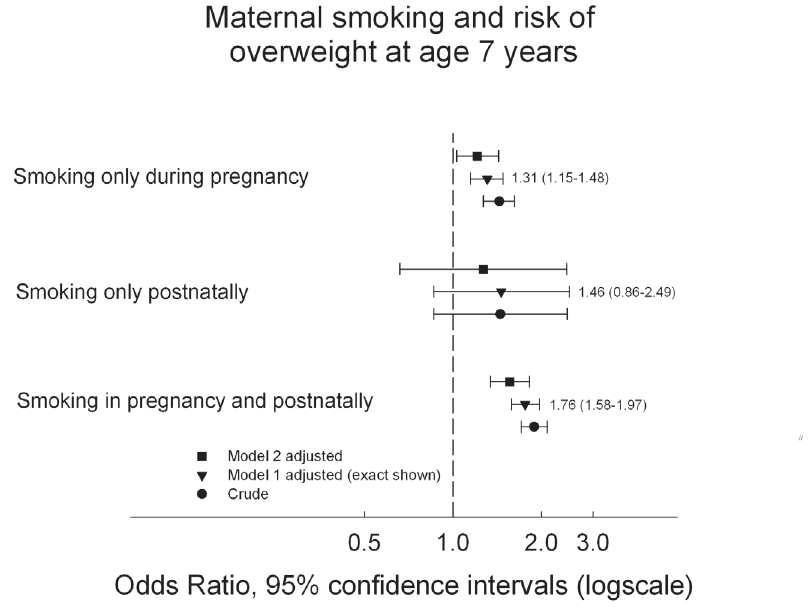
Figure 3. The figure shows the odds ratios with 95% confidence intervals of overweight at age 7 years by different exposure windows of maternal smoking pre- and postnatally. The reference group is children of non-smoking mothers. Model 1 analyses are adjusted